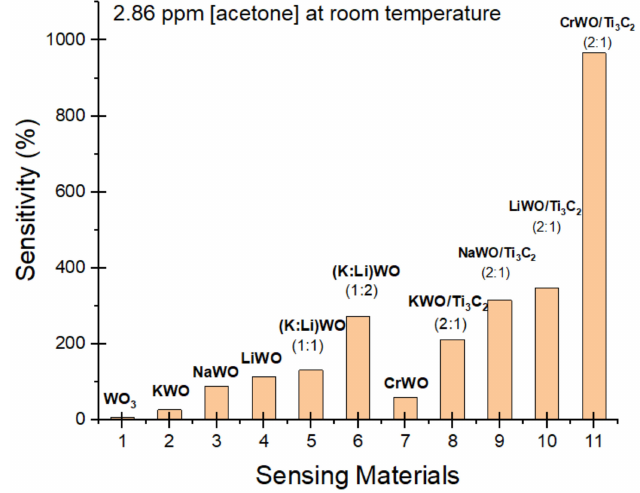
Figure 2. Results of the acetone (2.86 ppm) sensitivity test for various sensors. From left to right, the materials are WO 3 , KWO, NaWO, LiWO, K:Li (1:1), K:Li(1:2), CrWO, KWO/Ti 3 C 2 (2:1), NaWO/Ti 3 C 2 (2:1), LiWO/Ti 3 C 2 (2:1), and CrWO/Ti 3 C 2 (2:1). All sensors operated at room temperature. Table 1. Testing of various materials in comparison to the data of the materials tested for this paper. The bolded values in the table show results that were the most promising for the required conditions. The CrWO/Ti 3 C 2 sensor showed high sensitivity at a low operating